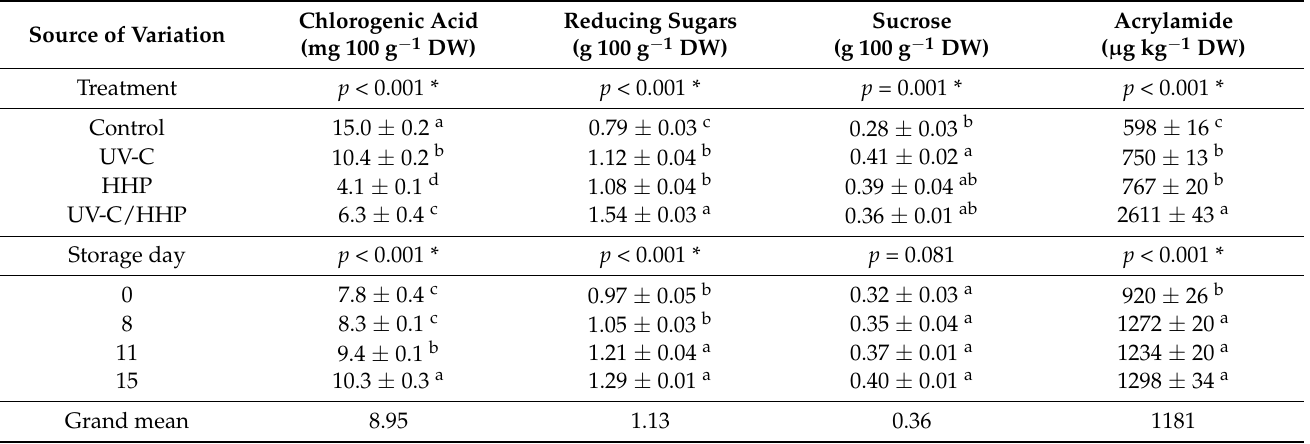
Table 3. The influence of UV-C, HHP, and UV-C/HHP treatment and storage time on the chlorogenic acid and sugar content of raw, fresh-cut potatoes.